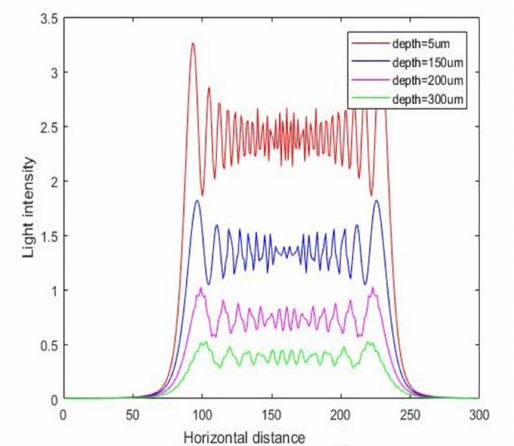
Figure 5. The intensity curve for vertical exposure with di ff erent depths.